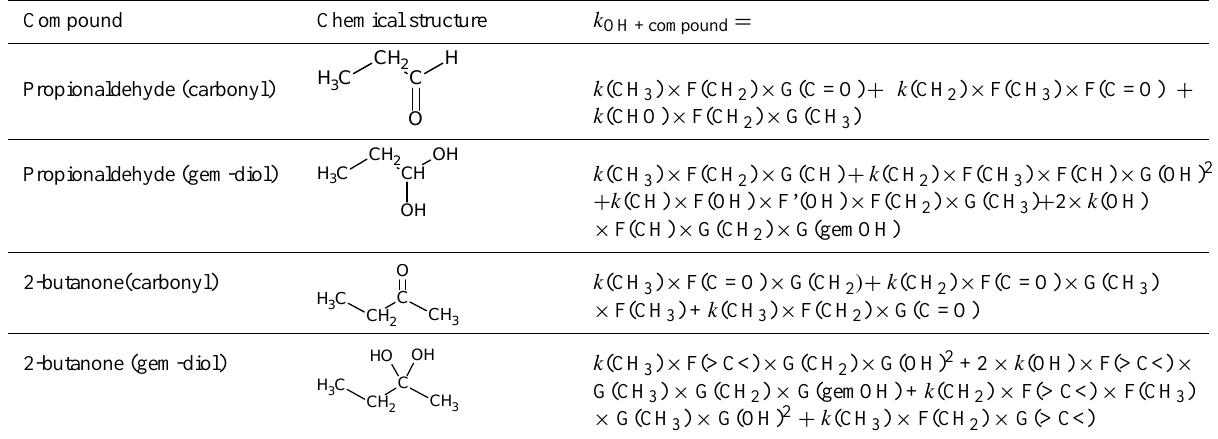
Table 3. Example of the calculation of the estimated aqueous phase rate constants of OH-oxidation of 2-butanone and propionaldehyde, and their corresponding gem-diols.